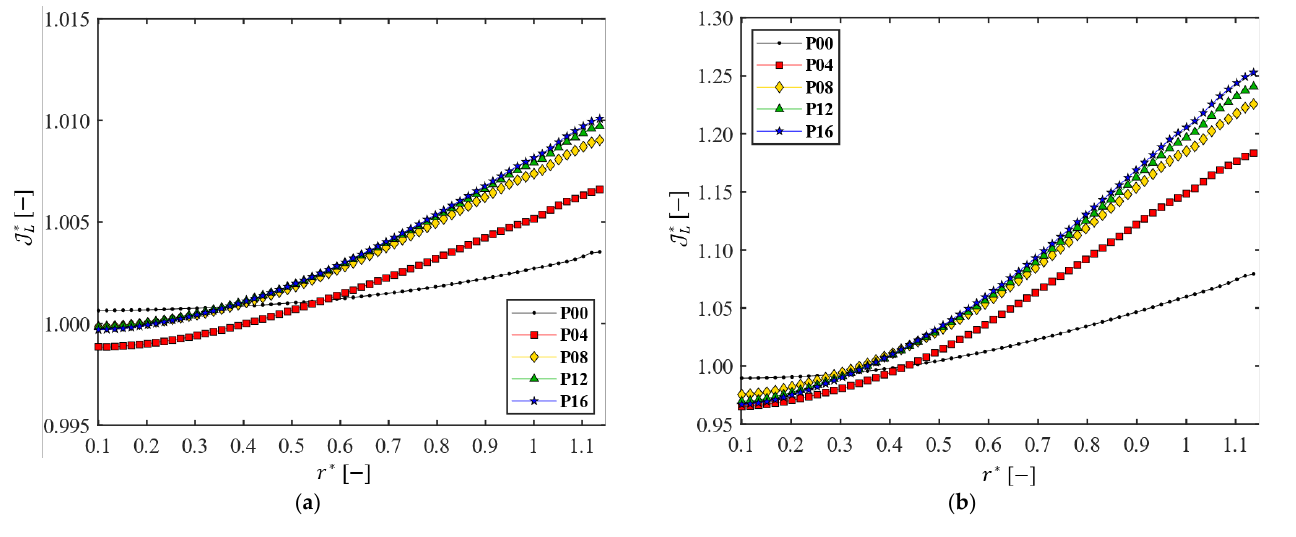
as functions of the dimensionless L